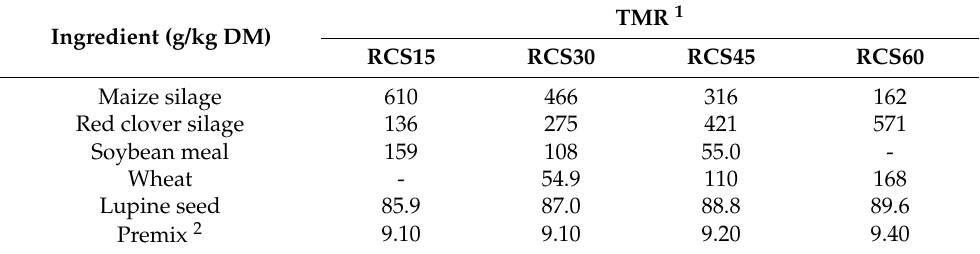
Table 1. Feed ingredients of the total mixed ratios (TMR).